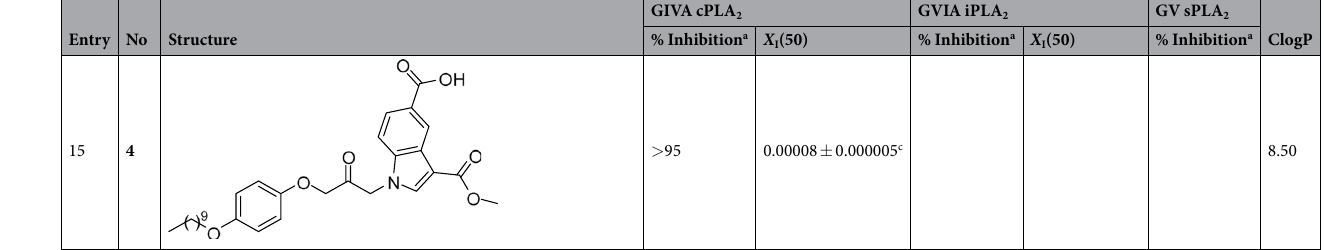
Table 1. In vitro inhibitory potency and selectivity of 2-oxoesters. a % Inhibition at 0.091 mole fraction of each inhibitor. b IC 50 4.3 nM in a vesicle assay 32